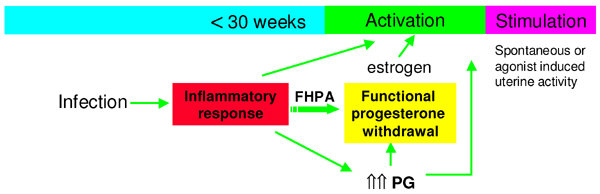
Schematic diagram to illustrate potential mechanisms by which infection/inflammation could influence uterine smooth muscle culminating in premature labour. Aspects of this model are also relevant to the processes influencing the cervix and fetal membranes. FHPA, fetal hypothalamic pituitary adrenal axis; PG, prostaglandins.